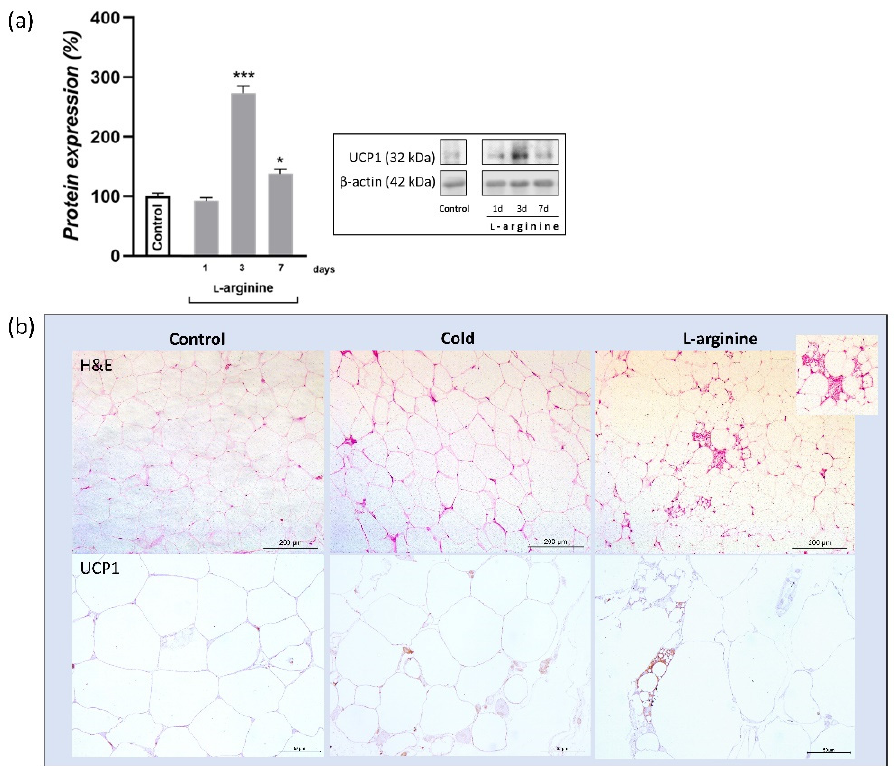
Figure 6. UCP1 protein expression level and tissue expression pattern in control, cold-exposed, and L -arginine-treated rats. Analysis of UCP1 protein expression after 1, 3, and 7 days of L -arginine treatment ( a ). Maximum induction of UCP1 was observed on day 3 of L -arginine treatment. Protein content is expressed relative to control rats (100%). Data represent the mean ± SEM. * Compared to control, * p < 0.05, *** p < 0.001. Experiments were repeated in triplicate. Data were quantified as described in the Methods. Analysis on the morphological level (H&E) indicates the simultaneous appearance of sporadic islets of multilocular cells selectively in retroperitoneal white adipose tissue (rpWAT) of L -arginine-treated rats ( b ). Inset, enlarged area of multilocular cells. Scale bars, 200 µ m. Immunohistochemical staining for UCP1 ( b , lower panel ) showed that, compared with very weak UCP1-immunopositive adipocytes in the control, stronger UCP1-immunopositivity characterized adipocytes in rpWAT of rats exposed to cold and treated with L -arginine for 3 days. Moreover, highly positive UCP1-positive multilocular adipocytes appear only in the L -arginine-treated group of rats. Scale bars, 50 µ